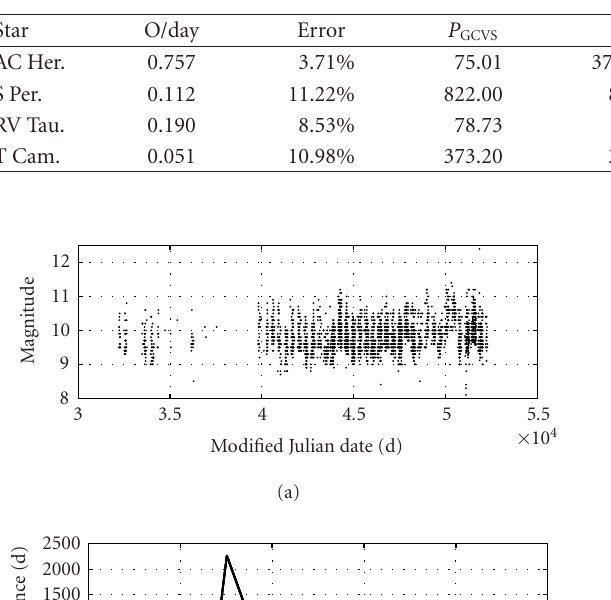
Table 1: Results for the four variable stars (column 1). The sampling quality is defined by the mean number of observations per day (column 2). The reconstruction error computed for the matching pursuit analysis is presented (column 3). The known period and those found with the di ff erent analyses are indicated (columns 4–8): periodogram ( P Perio ), GWS ( P GWS ), matching pursuit decomposition ( P MP ), and weighted wavelet Z -transform ( P WWZ ). In the WWZ, c = 0 . 005 for data of S Per. and T Cam., c = 0 . 04 for AC Her, and c = 0 . 0125 for RV Tau. In brackets: double periods are also found and are corresponding to the periods indicated in the fourth edition of the General Catalog of Variable Stars.